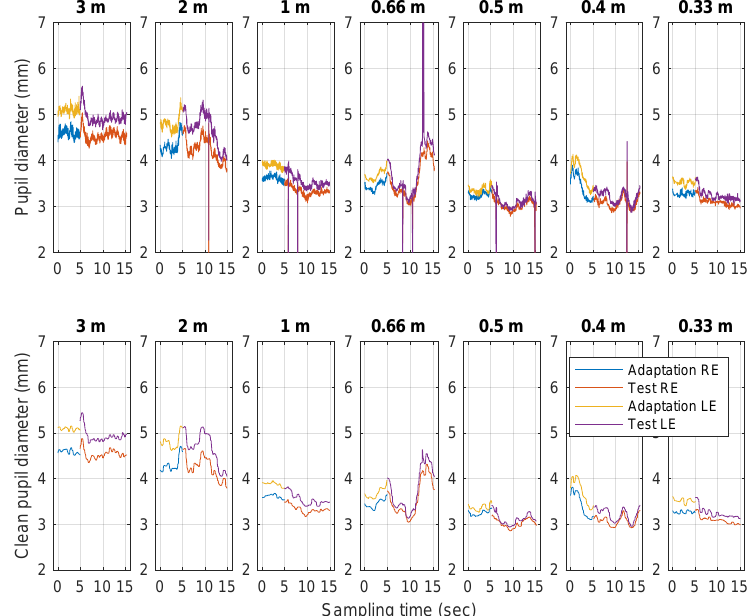
Figure 1. Pupil diameter recordings during 15 s and for the different observing distances. Upper set: The raw data for the RE and LE. Lower set: The pupil sizes after blink removal for the RE and LE using the Hampel